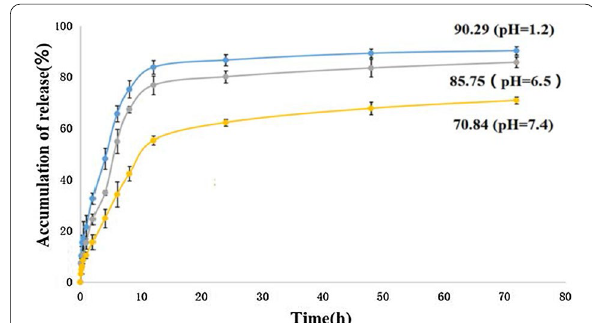
Fig. 10 In vitro release curves of 5-FU-Tau-GO in phosphate saline at 37 °C